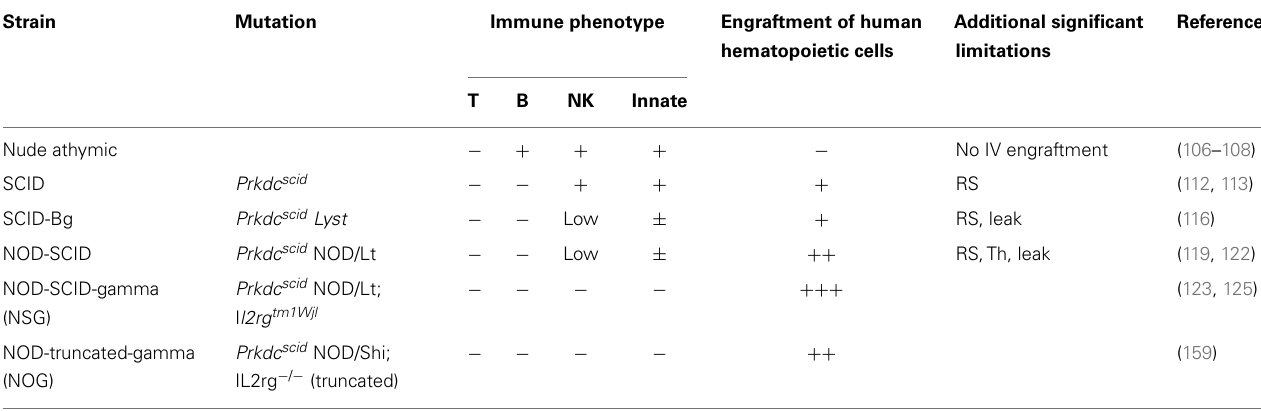
Table 2 | Xenograft mouse strains used in human leukemia research